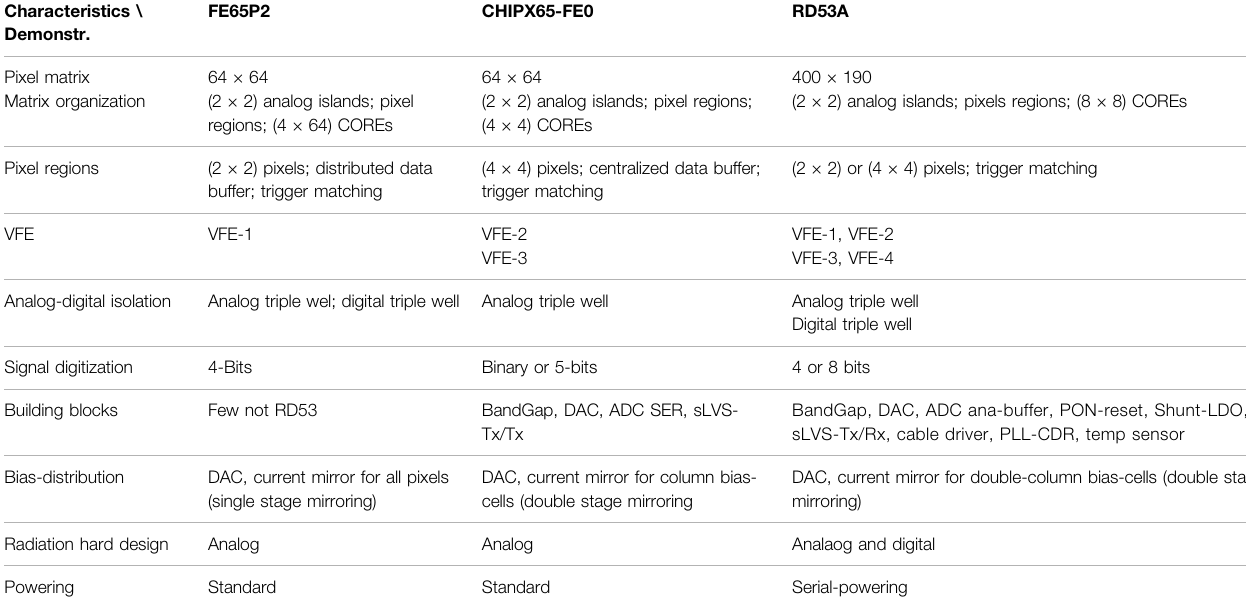
TABLE2| TablewiththedifferentcharacteristicsofFE65P2,CHIPIX-FE0,RD53Ademonstrators,producedonSept-2015,July-2016andAug-2017respectivelyFrom[16]. Characteristics \ Demonstr.